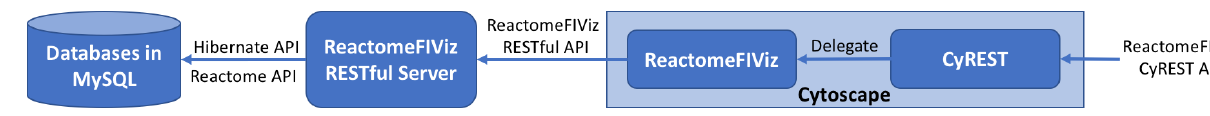
Figure 1. Software architecture for ReactomeFIViz CyREST